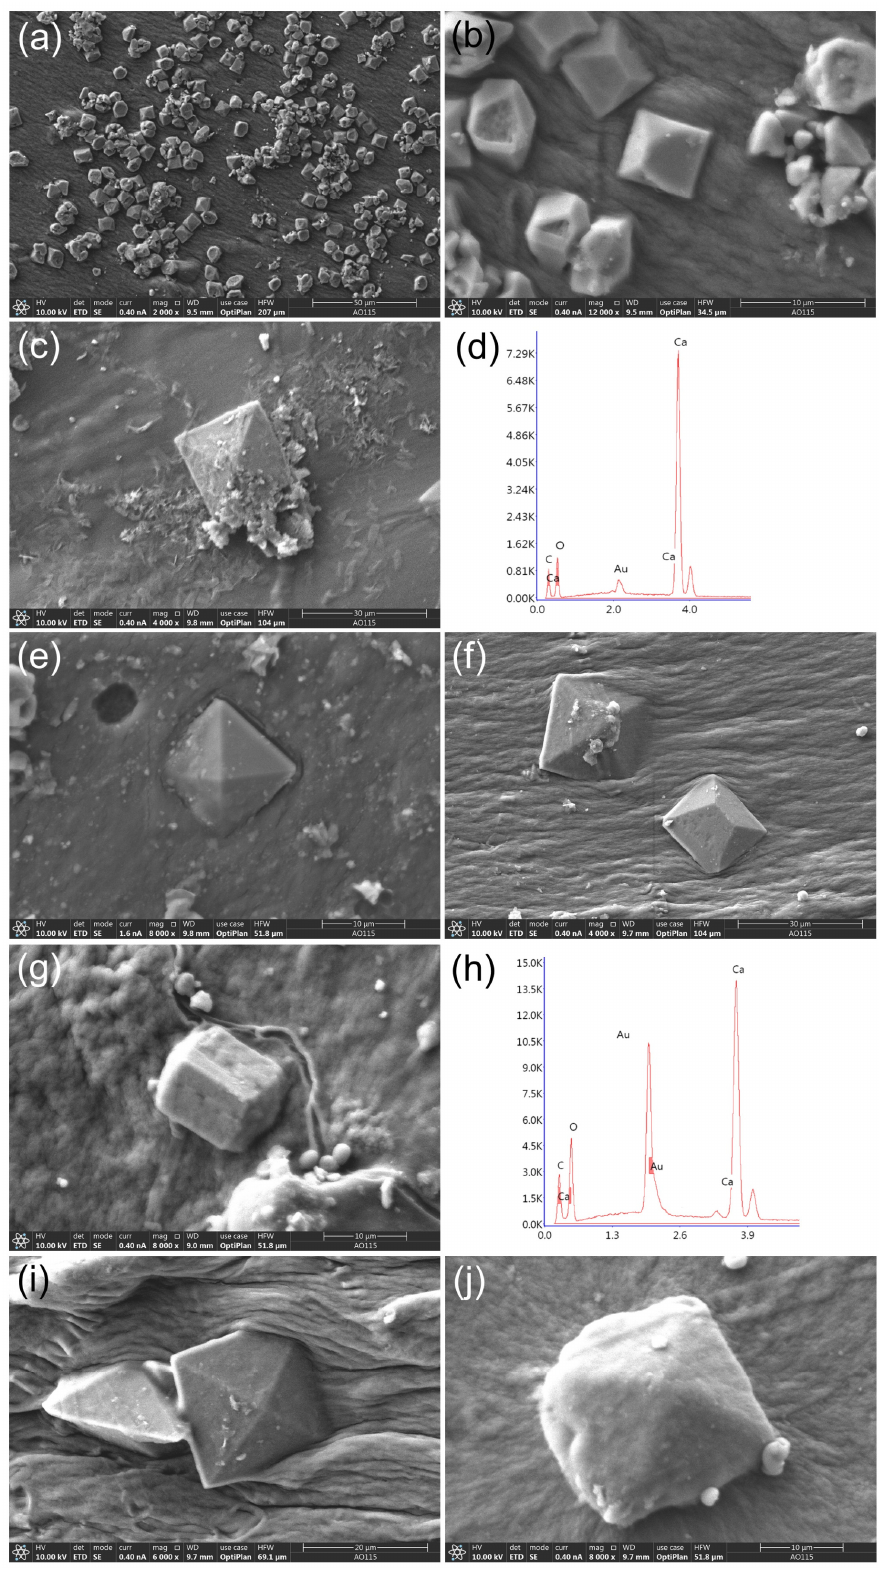
Figure 9. SEM analysis of the crystals precipitated by acid-producing strains (day 7, MB4 medium). ( a , b ) P. cfr. rubens ; ( c ) P. cfr. chrysogenum ; ( d ) EDS spectrum corresponding to ( c ); ( e ) P. cfr. citrinum ; ( f , g ) C. cfr. sphaerospermum ; ( h ) EDS spectrum corresponding to ( g ); ( i , j ) Penicillium sp. ( b , g , j ) Calcite crystals (CaCO 3 ); ( a , c , e , f , i ) weddellite (CaC 2 O 4 · 2H 2